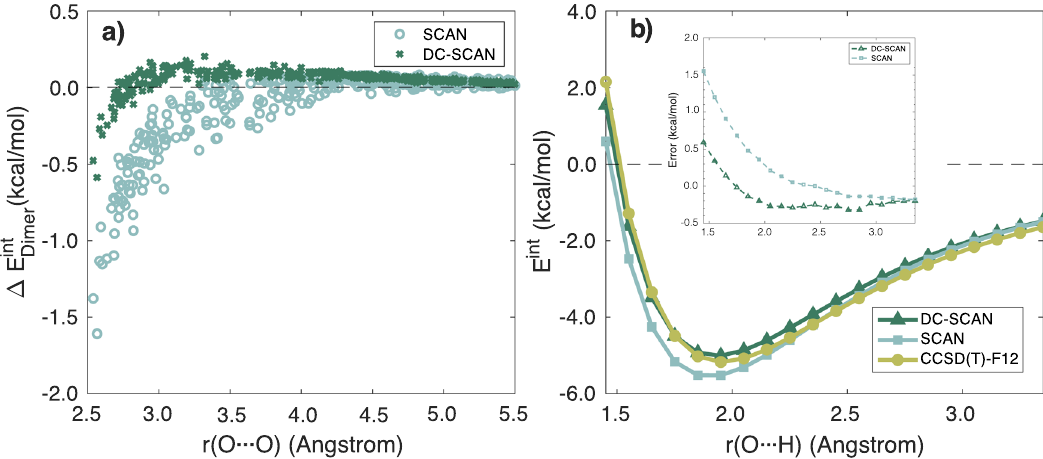
Fig. 2 Comparison of dimer interaction energies. a Errors in 2-body energies calculated with SCAN and DC-SCAN relative to CCSD(T)-F12b values for dimers with an oxygen − oxygen distance shorter than 5.5 Å which were extracted from an NPT simulation of liquid water carried out with MB-pol 79 − 81 at ambient conditions. b CCSD(T)-F12b, SCAN and DC-SCAN interaction energies calculated for an unrelaxed scan of the water dimer along the O ⋯ H distance. The inset of panel ( b ) shows the errors associated with DC-SCAN and SCAN relative to the CCSD(T)-F12b reference values as a function of r(O ⋯ H).